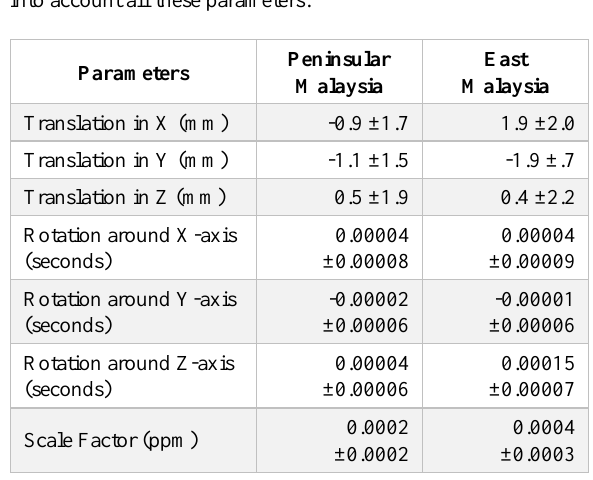
Table 4. Transformation parameters between processed/combined IGS coordinates and the weekly IGb08 frame coordinates at epoch 2013.5027